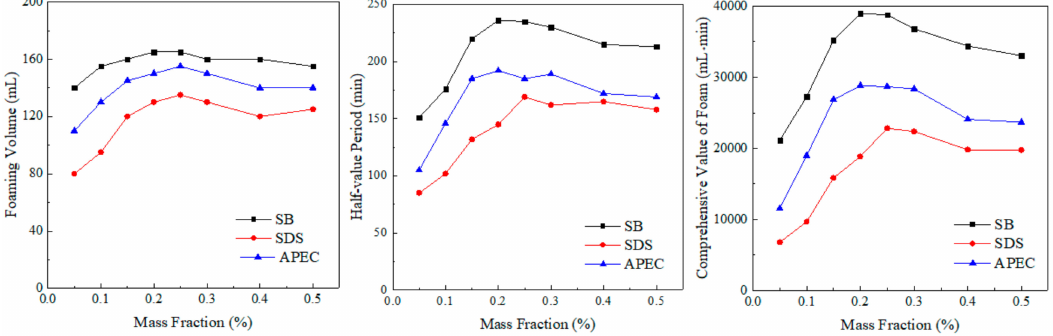
Figure 3. Foaming performance of different foaming